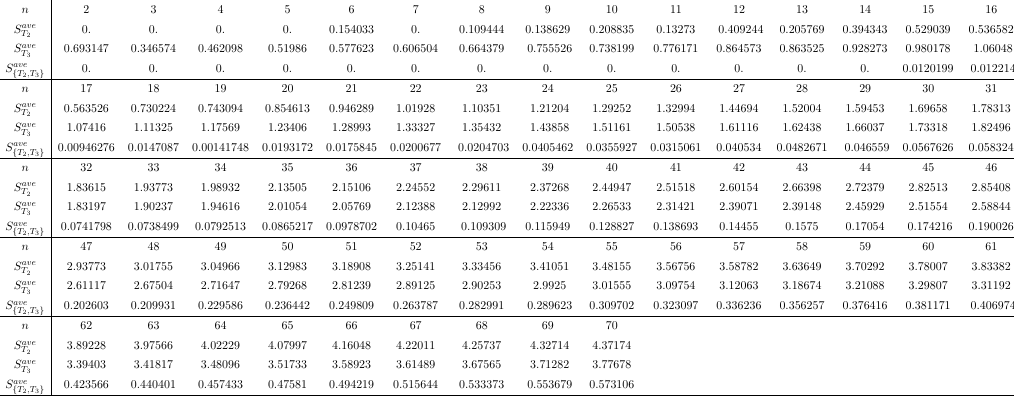
, S ave and S ave : T 2 T 3 T 2 ;T 3 f g